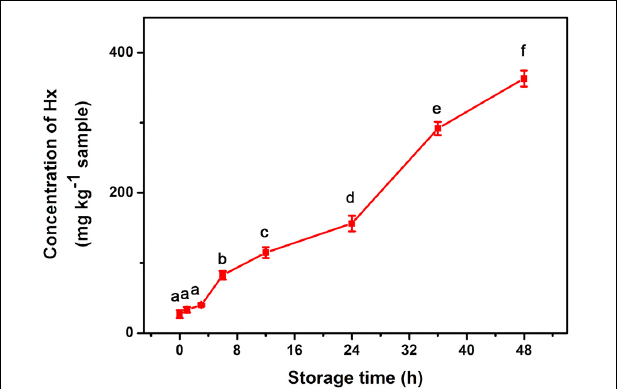
FIGURE 4 | Detection of Hx in sea bass fish sample during storage for 48 h at room temperature. Different lowercase letters indicate Hx concentrations in fish samples of different storage time are significantly different ( p <